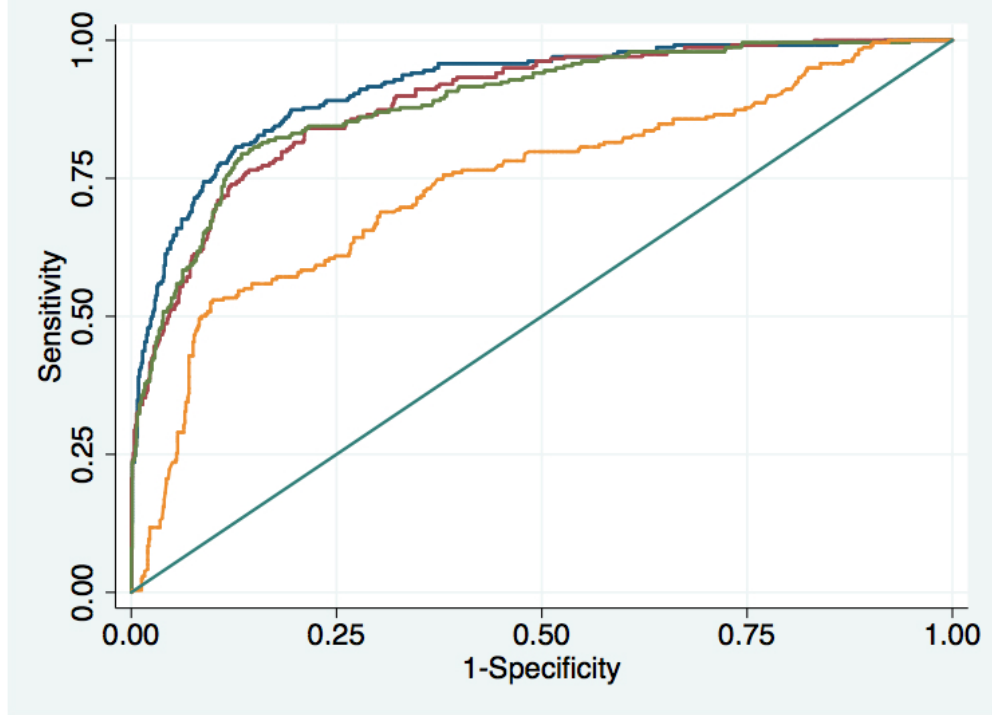
Figure 1. Receiver Operator Characteristic (ROC) curves for models predicting patient reports of moderate/severe depression, as measured by a PHQ-9 score ≥ 10.